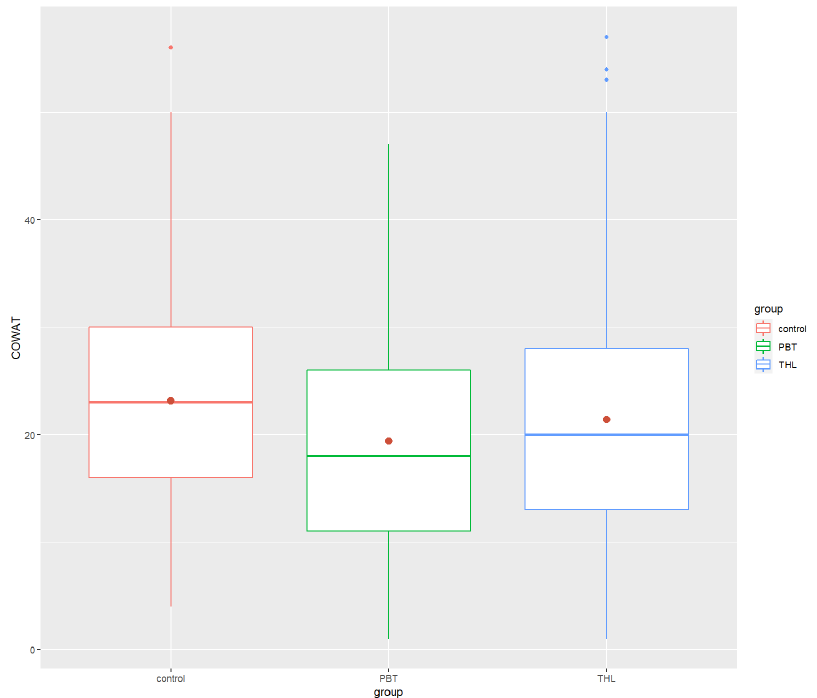
Figure 3. Boxplots of COWAT for the healthy control group and the diagnosis groups. Control — healthy control group, PBT — pediatric brain tumor survivors, THL — hematopoietic and lymphoid tissues tumor survivors. COWAT — Controlled Oral Word Association Task. Red dot — mean test score for each group.